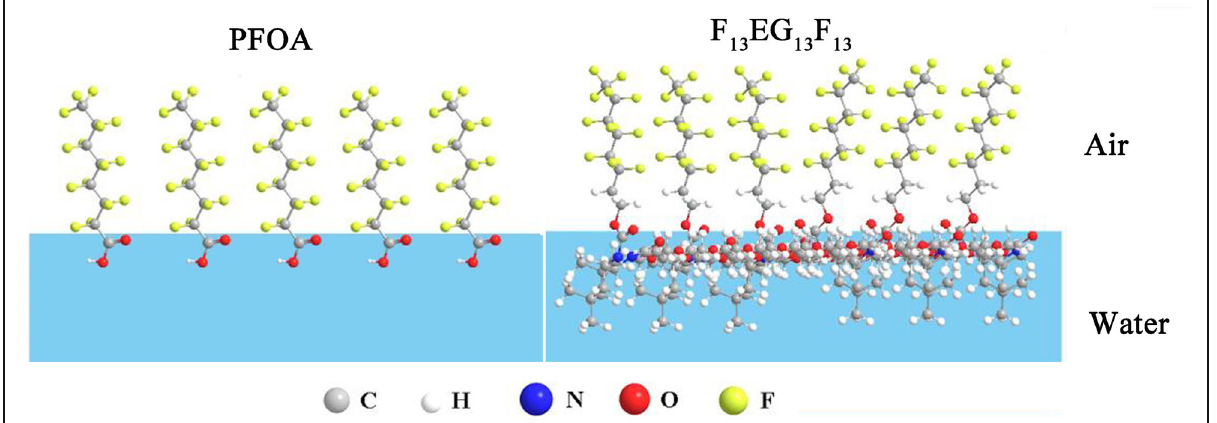
Fig. 2 Schematic representation of adsorption behavior for PFOA and F 13 EG 13 F 13 molecules at the air-water interface [60]. Copyright 2019,